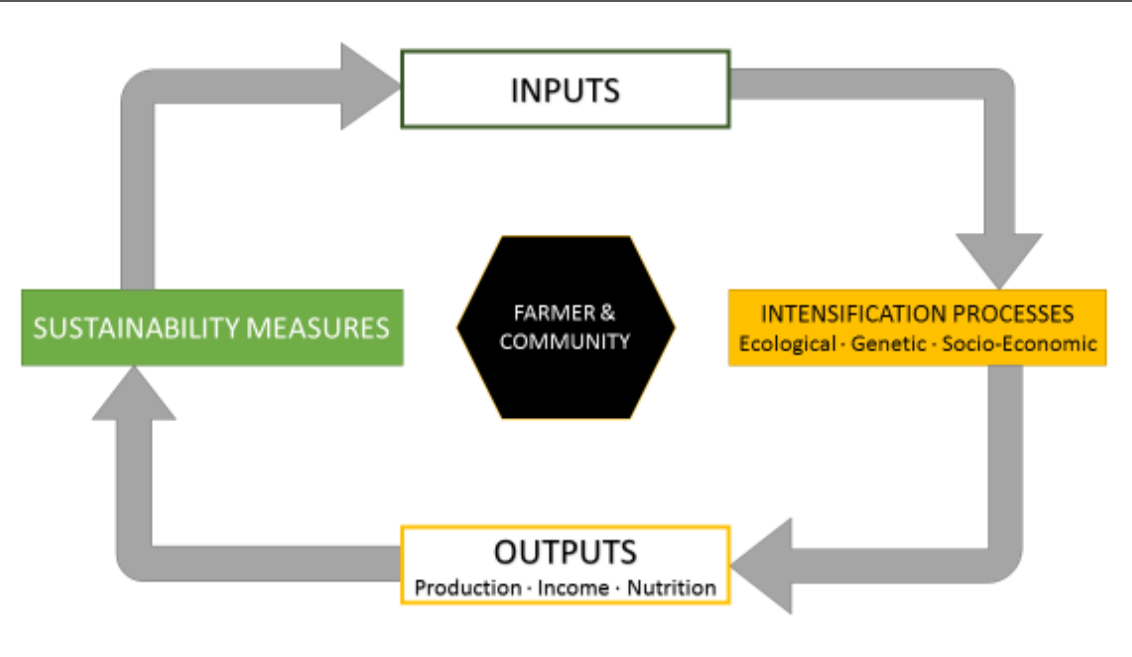
Adapted from Agriculture for Impact, 2013, p.